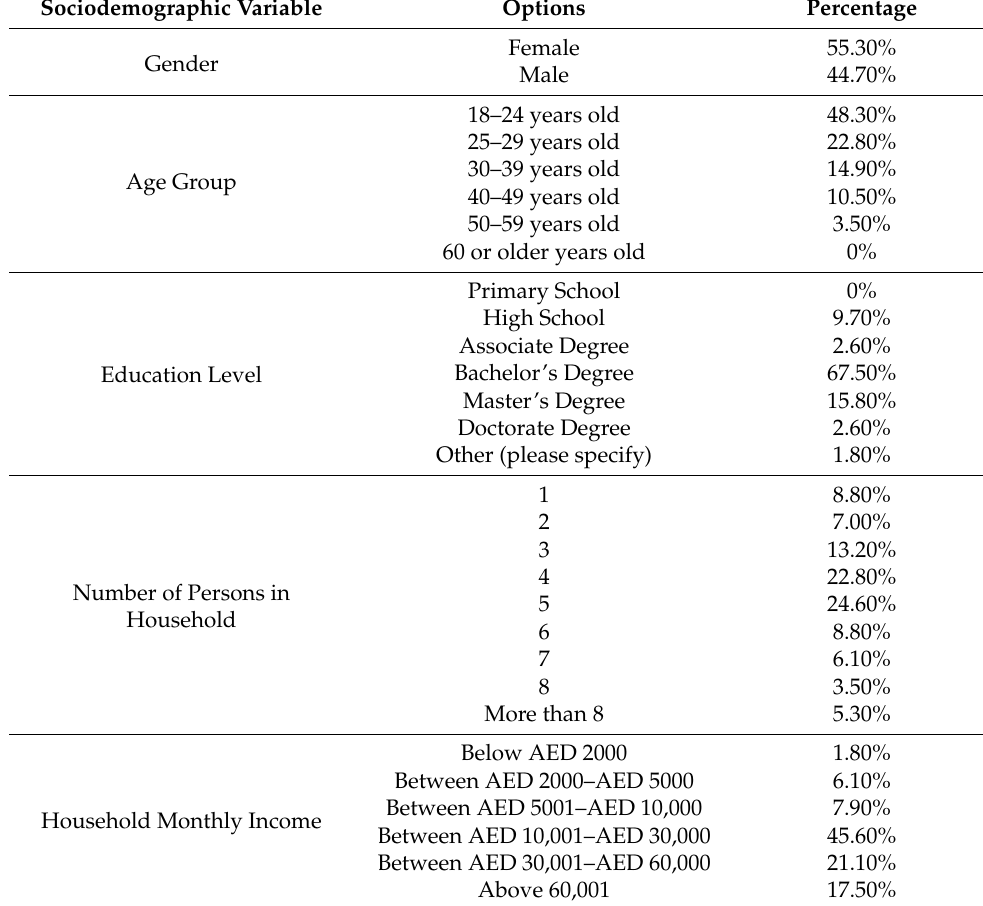
Table 6. Sociodemographic